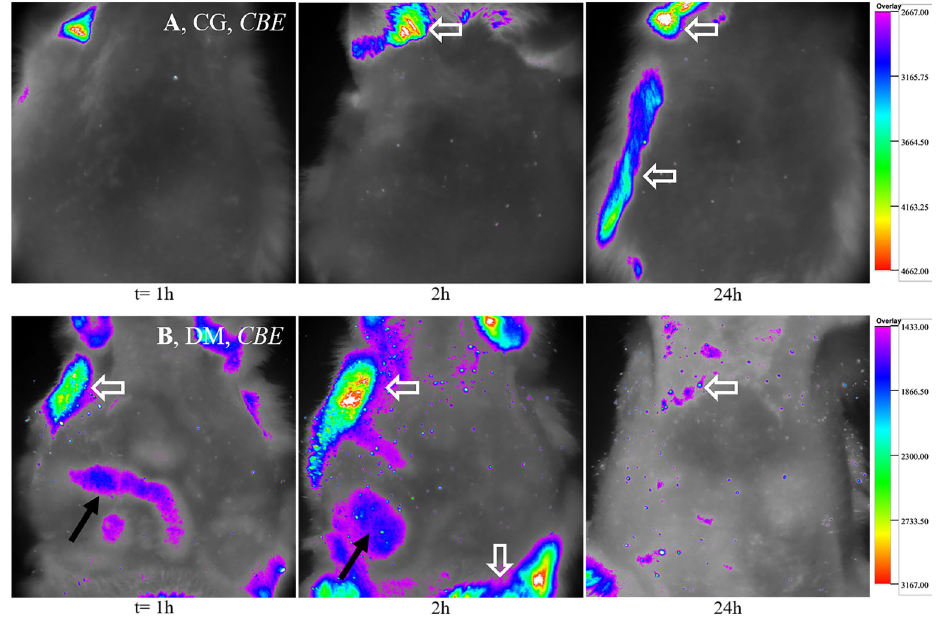
Figure 3. In vivo images of the abdominal region of Wistar rats from control animals (CG) ( A ) and type 1 diabetic animals (DM) ( B ) groups. CBE: chlorophyll-based extract. The intensity of the body fl uorescence, presented as RLU/pixels per 30 s, was evaluated at different times (h) after gavage. The narrow black arrows signal the fl uorescence emission of the compound present in the intestinal loop of the animals. The broad white arrows represent fl uorescence artifacts produced by the hairs of animals, as well as other unlabeled fl uorescent sites.